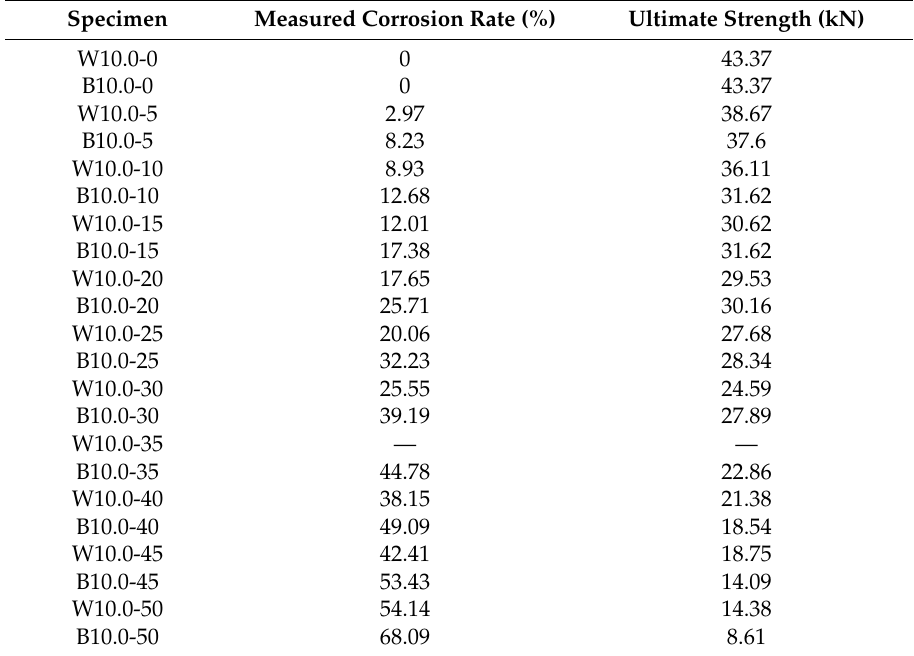
Table 5. Ultimate strengths of the 10.0 mm series single stud specimens.